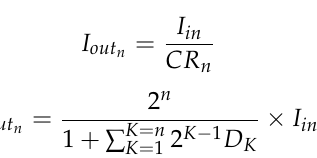
code = (010110) 2 ; and ( b ) B code = (001100) 2